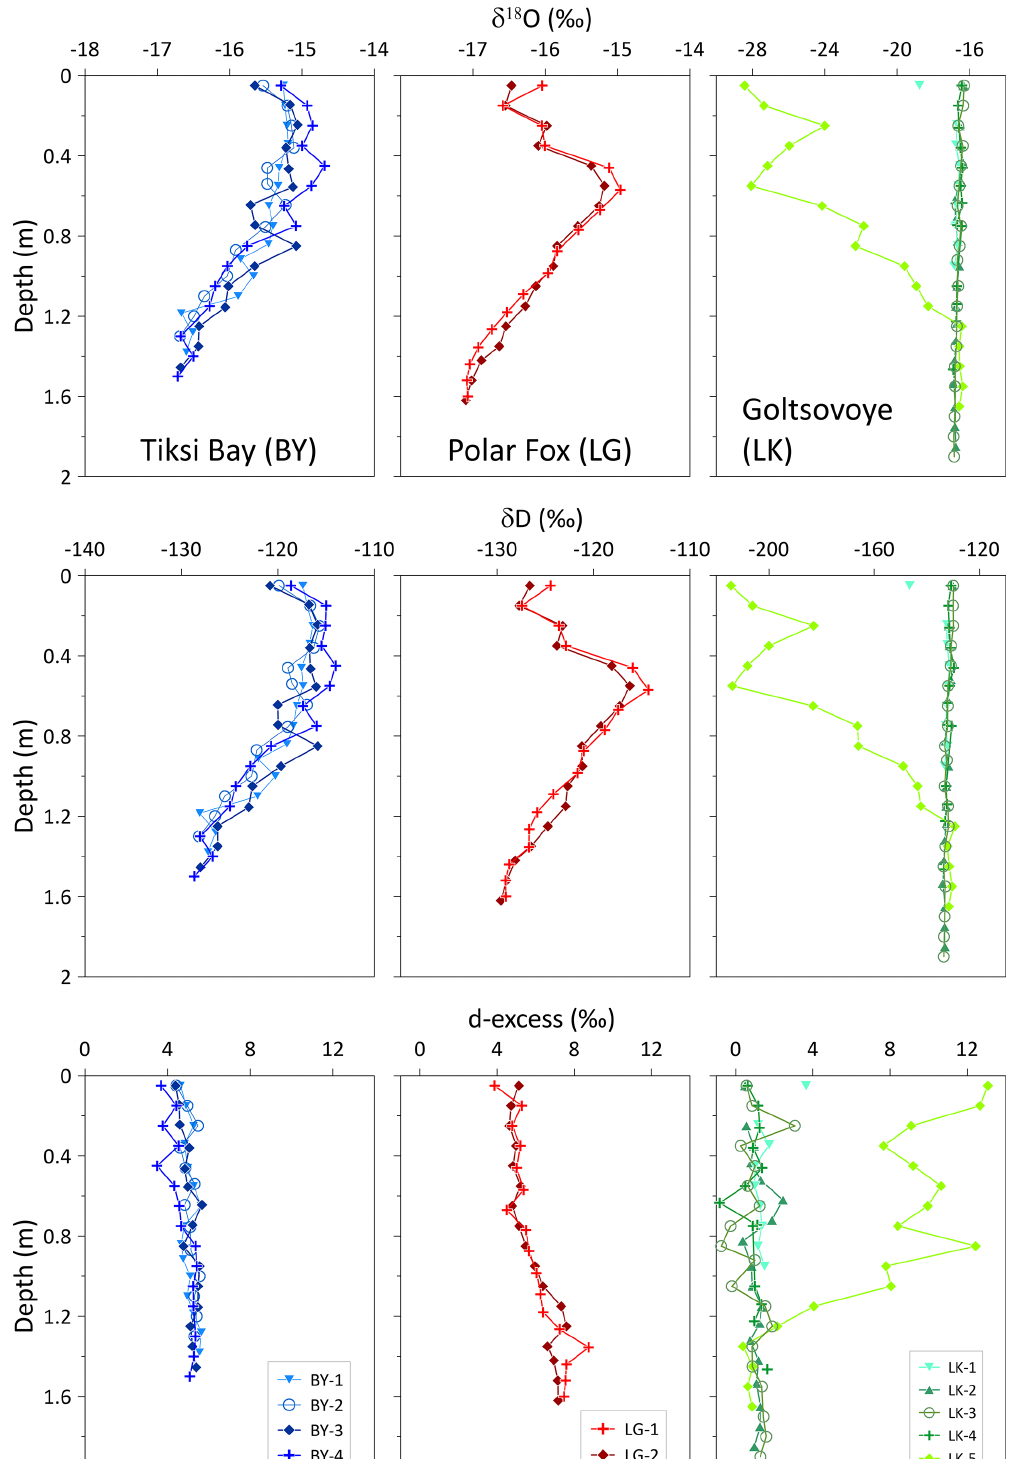
Figure 5. Vertical distribution of the stable water isotopic compositions ( δ 18 O, δ D and d-excess) in ice cores with depth. Note that the isotope composition scales for Goltsovoye Lake (LK, at right) differ from the other two sites to accommodate the values observed in core LK-5.